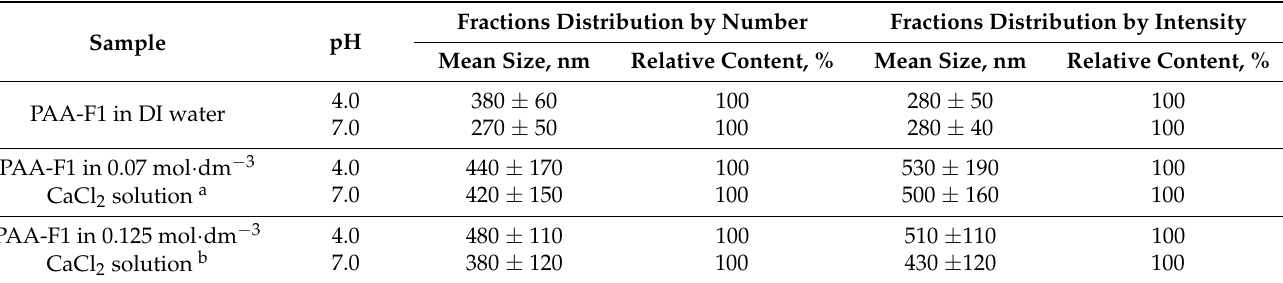
Table 4. DLS analysis of 10 mg · dm − 3 PAA-F1